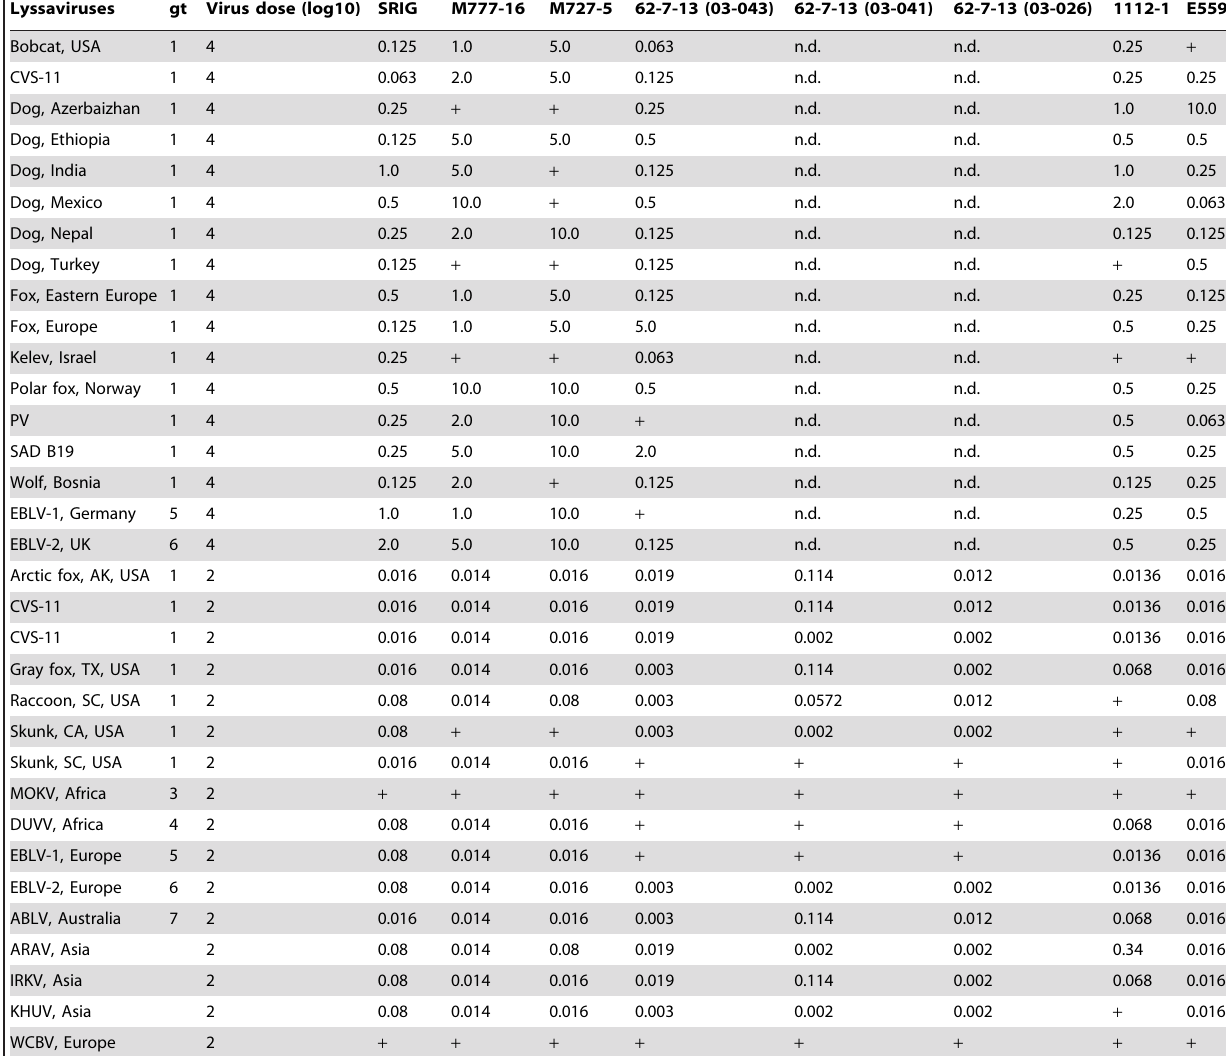
Table 3. In vitro neutralization pattern of individual candidate